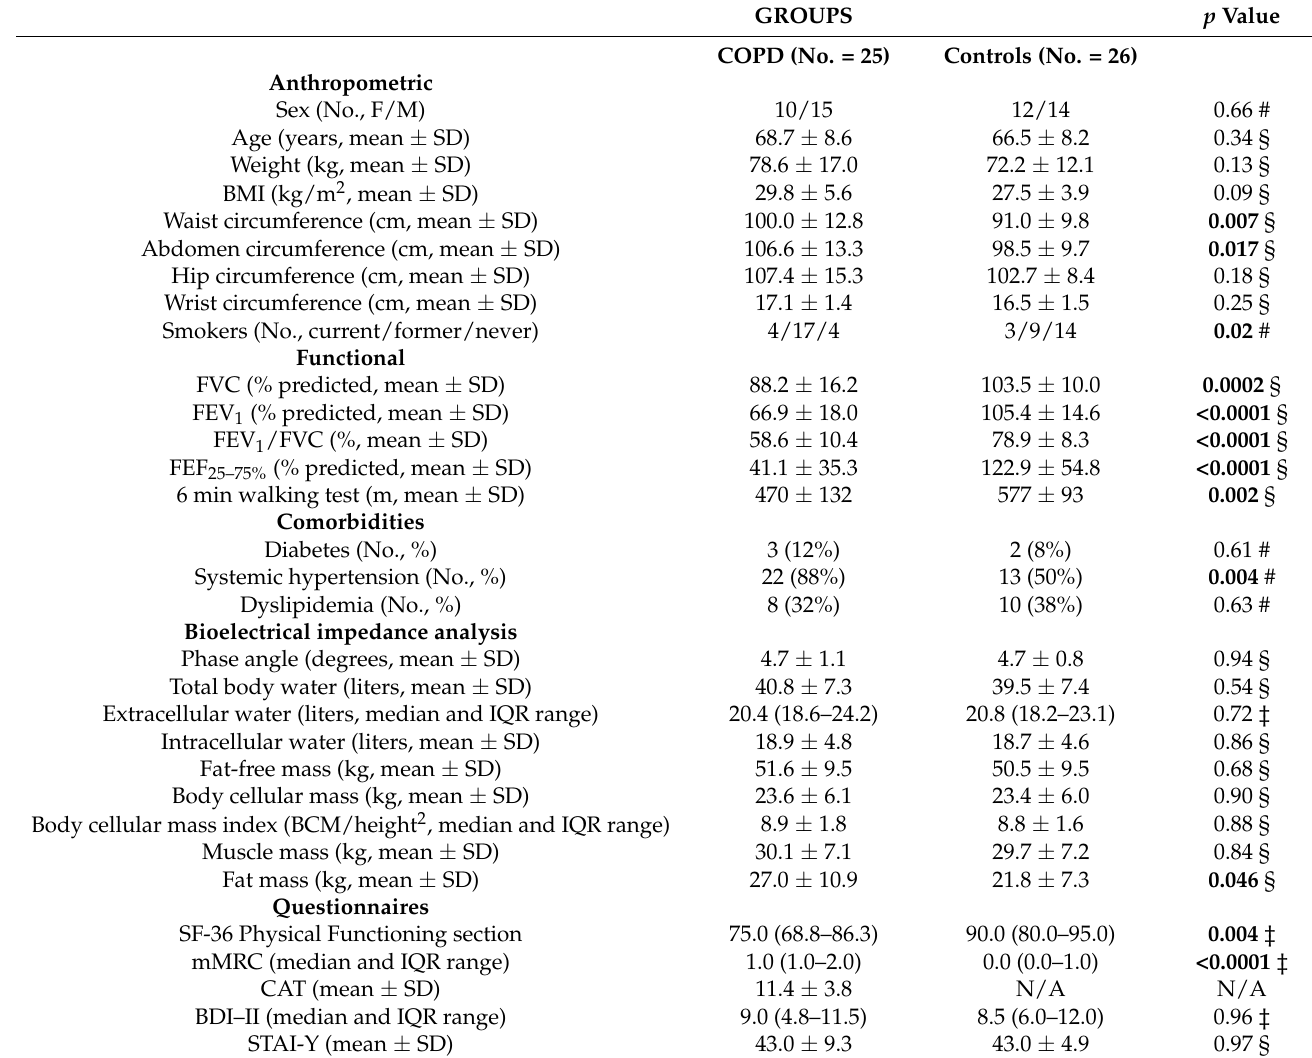
Table 1. Anthropometric and pulmonary function data, bioelectrical impedance analysis parameter evaluations, and questionnaire data of enrolled